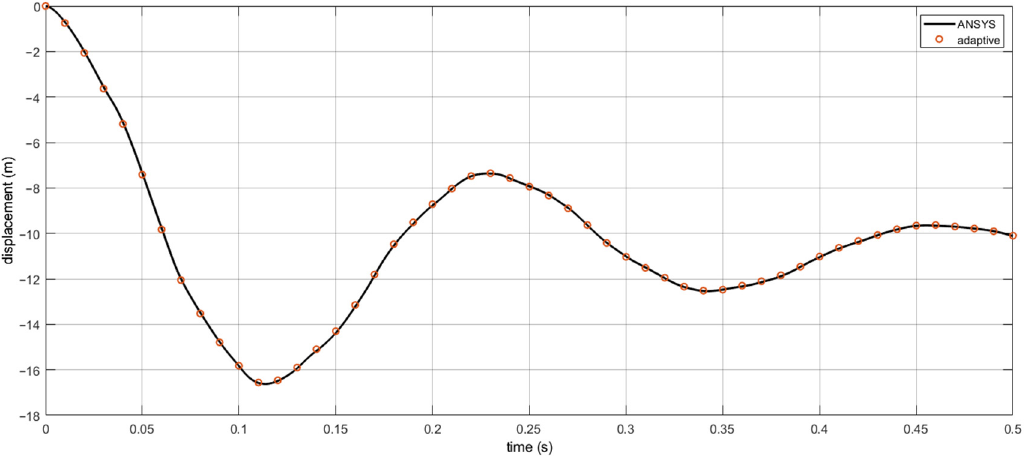
Figure 15. The transient vertical displacement at point A with damping ( 𝑐 = 10 Ns/m ), Δ𝑡 = 0.005 s , under Heaviside step loading with an infinite duration.